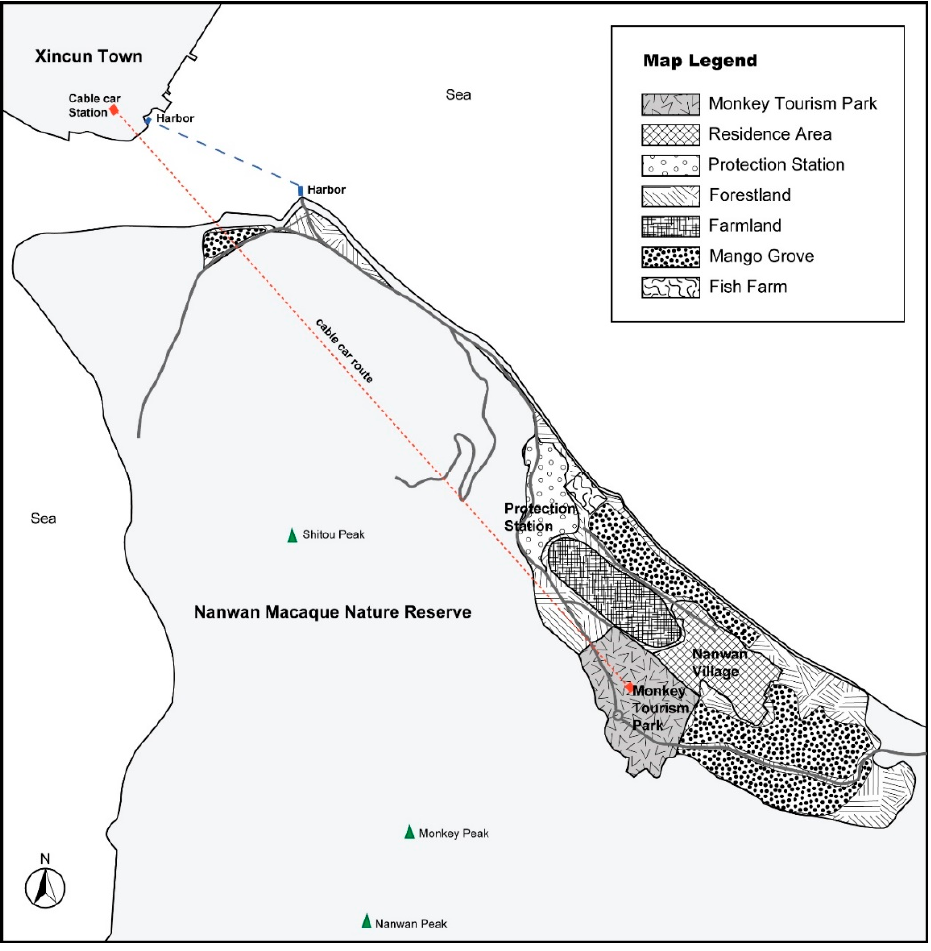
Figure 1. Map of the study site.